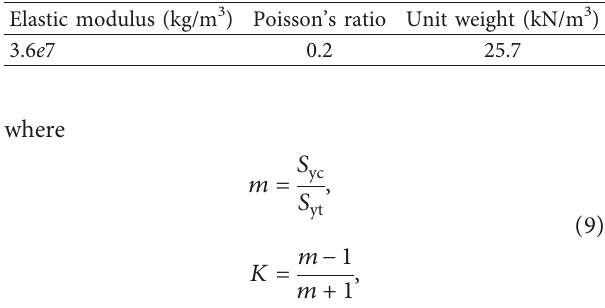
Table 2: Properties of the tunnel.